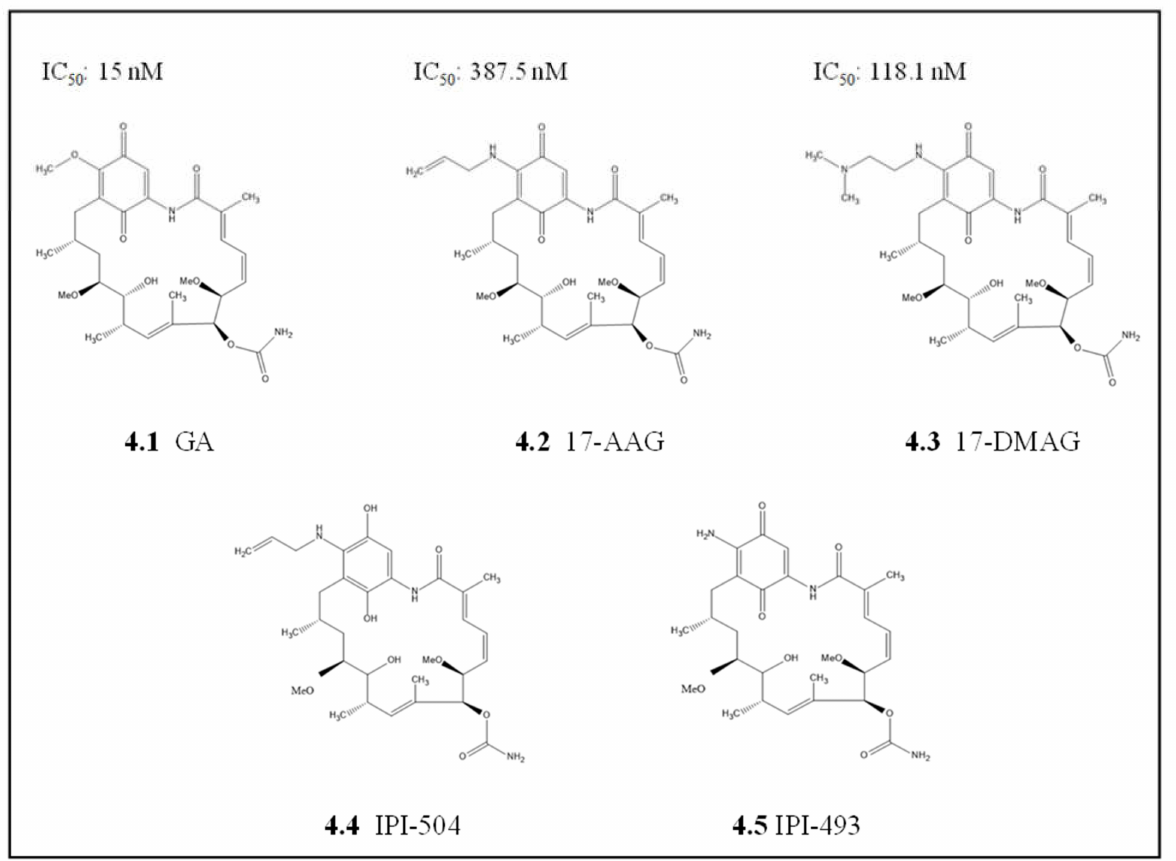
Figure 4. Chemical structure of geldanamycin and its derivatives. 4.1 Geldanamycin (GA) is a natural Hsp90 in- hibitor and its derivatives 4.2 17-allylamino-17-demethoxygeldanamycin (17-AAG), 4.3 17-dimethylamino ethylamino-17- demethoxygeldanamycin (17-DMAG), and 4.4 17-allylamino-17-demethoxygeldanamycin hydroquinone hydrochloride (IPI-504). 4.5 17-amino-17-demethoxygeld anamycin (IPI-493) is a major metabolite of both IPI-504 and 17-AAG. The P. falciparum growth inhibition IC50 values are